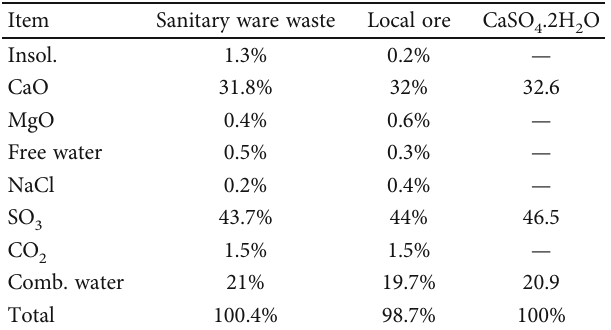
Table 4: Chemical analysis of sanitary ware wastes compares with local gypsum ore and pure gypsum.